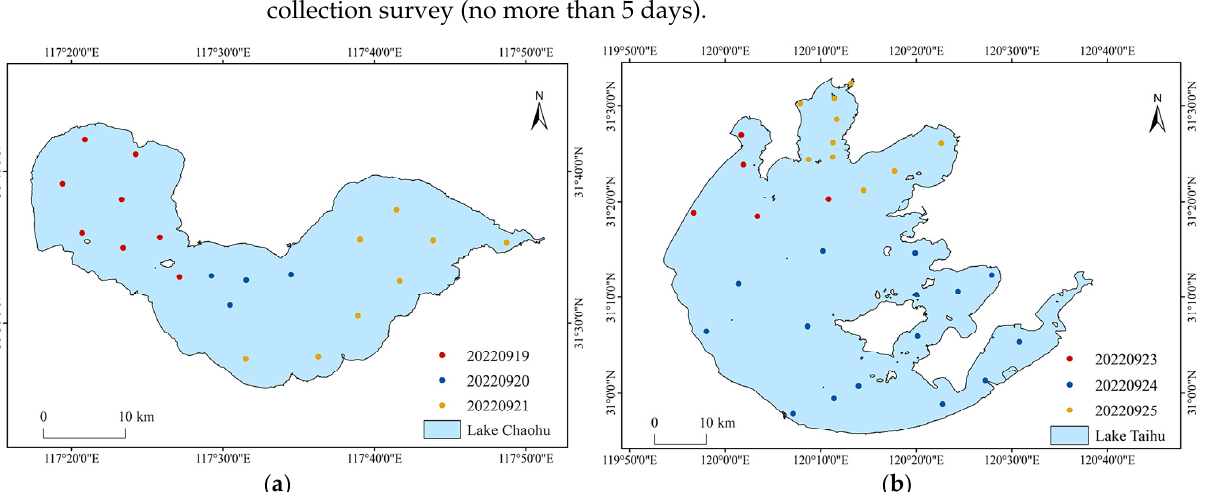
Sensors 2023 , 23 , x FOR PEER REVIEW